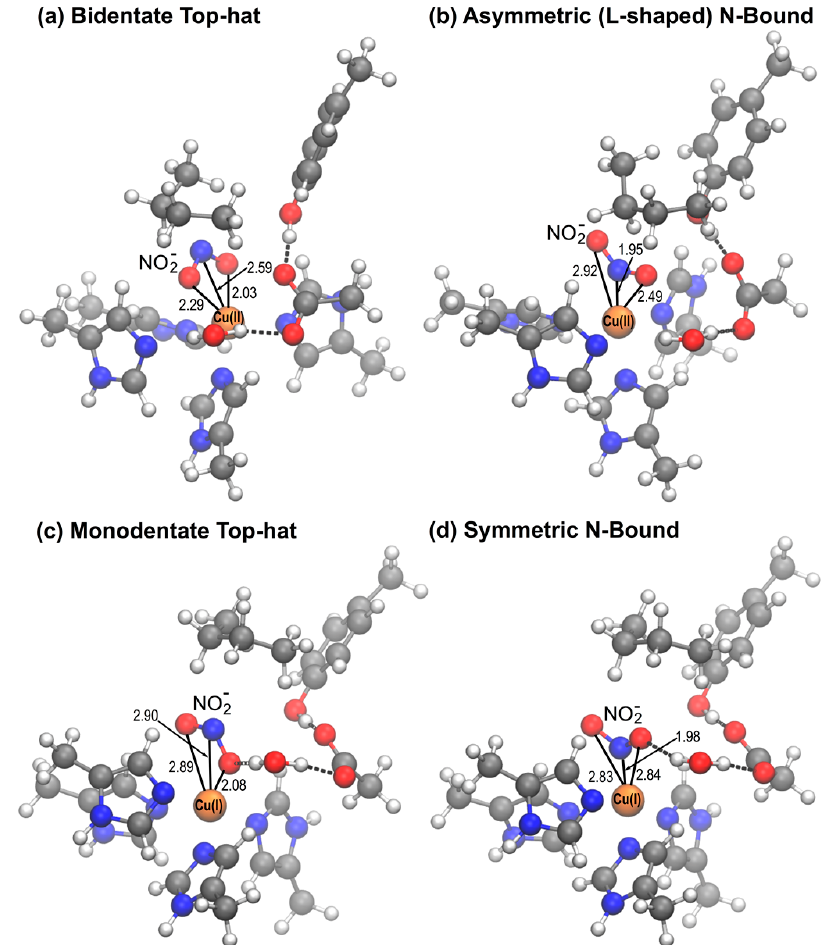
Figure 4. Representative structures of different orientations of NO 2 − bound to T2Cu as classified by the geometric angles θ and ψ . ( a ) bidentate top-hat orientation, seen only in the Cu(II) state, ( b ) L -shaped N-bound orientation, more common in the Cu(II) state, ( c ) monodentate top-hat orientation observed in relaxed top-hat geometries after reduction to Cu(I), ( d ) symmetrical N-bound orientation observed in both the oxidised and reduced states on relaxation from the N-bound state. Figure 5 shows the overlay of the X-ray structures of the nitrite-bound D97N mutant [20] and two simulated conformers, from the D97 and D97N systems, with similar L -shaped NO 2 − orientations bound to Cu(II). In both systems, the Tyr323 was oriented in the substrate access channel as in the native Rp NiR crystal structure, rather than being displaced as observed experimentally for D97N. Apart from the difference in the Tyr323 position, the orientation of NO 2 − , the coordinated histidines and the other active site residues are all similar to the observed X-ray structure. In the crystal structure θ is 4.9 ◦ and ψ is 45.2 ◦ and the corresponding angles from the optimized structures are θ : 5.8 ◦ , 3.5 ◦ and ψ : 11.3 ◦ , 16.3 ◦ . Our findings indicate that the X-ray structure is consistent with the L -shaped N-bound NO 2 − orientations observed for the Cu(II) state in Rp NiR and not the reduced Cu(I) state (SI, Figure S2), owing to the symmetrical N-bound orientation we observe in the reduced state. Such an L -shaped orientation is not primarily observed for two-domain CuNiRs in the Cu(II) state where a bidentate top-hat orientation of NO 2 − is mostly